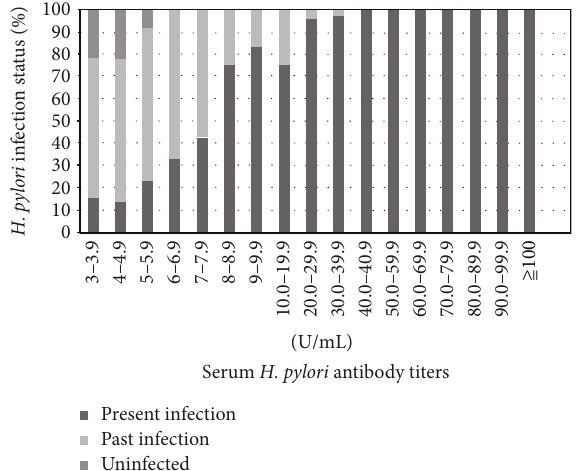
Figure 2: Relationship between Hp Ab titers and Hp infection status ( n = 381 ). As the Hp Ab titers increased, the rate of present infection tended to increase, but conversely, the rate of past infection tended to decrease. Uninfected patients all had titers <